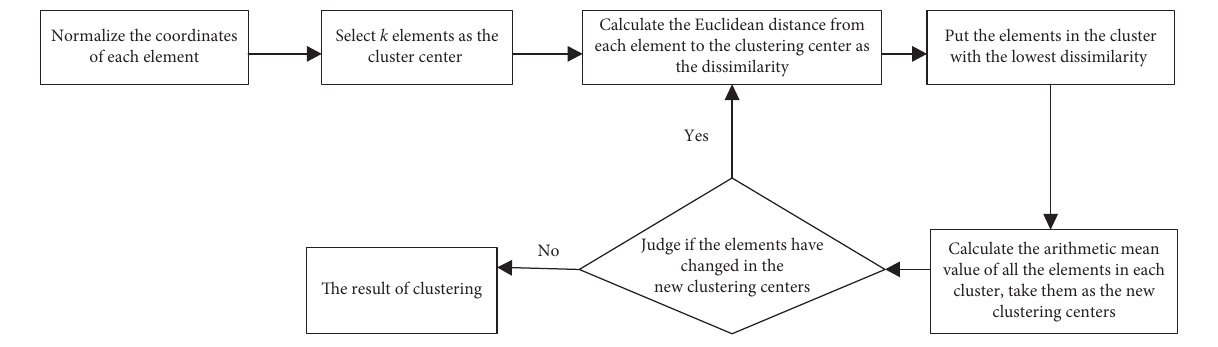
Figure 3: Steps of the k -means clustering method. Table 1: Notations and